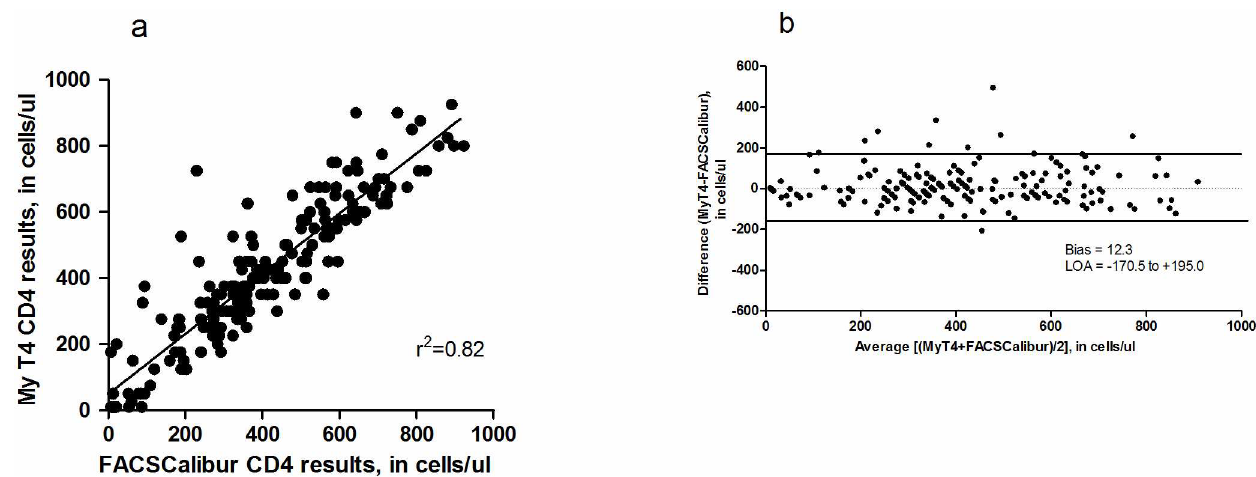
Fig 1. Regression plot (a) and Bland-Altman difference plot (b) for comparison of the MyT4 with the BD FACSCalibur ™ . (a) In the Bland-Altmandifference plot the vertical axis is the difference between the CD4 counts from the two methods while the horizontal axis is the average CD4 count from each